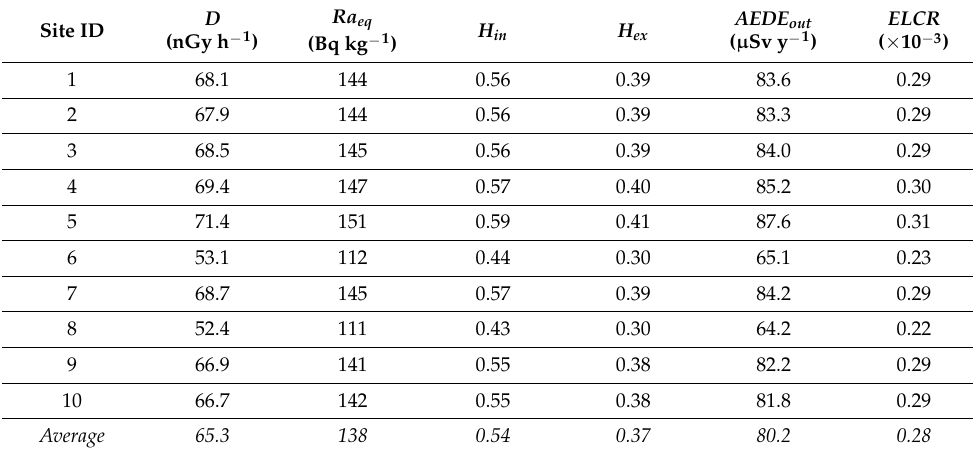
Table 5. Radiological hazard indices in the investigated sampling sites.